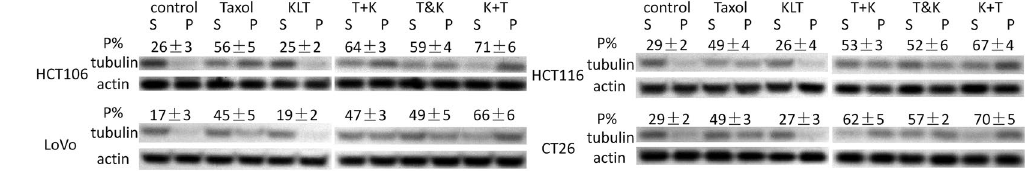
Figure 2. Western blotting analysis of α -tubulin polymerization in four colorectal cancer cell lines: HCT106, HCT116, LoVo, and CT26. Where “t + K” represents “Taxol + KLT”, “t & K” represents “Taxol&KLT” and “K + t” represents “KLT + Taxol”, respectively. Six different drug treatment groups are listed in the top row and are defined in “Kanglaite and Taxol treatment”. “S” represents soluble tubulin and “P” represents polymerized tubulin. Each densitometric value of tubulin was normalized to the densitometric value of β -actin. The percentage of polymerized tubulin was obtained by dividing the densitometric value of the polymerized tubulin P by the total tubulin content: + P S